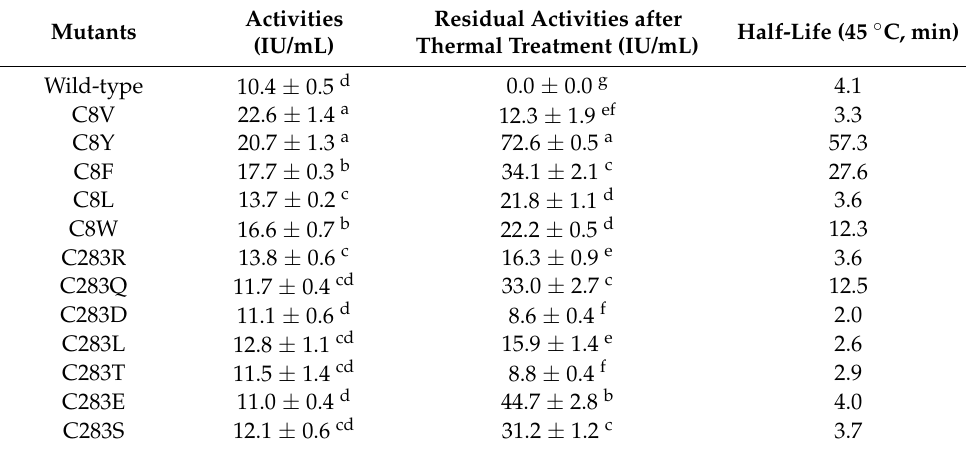
Table 1. Activities and half-lives of cysteine residue mutants of AsA.